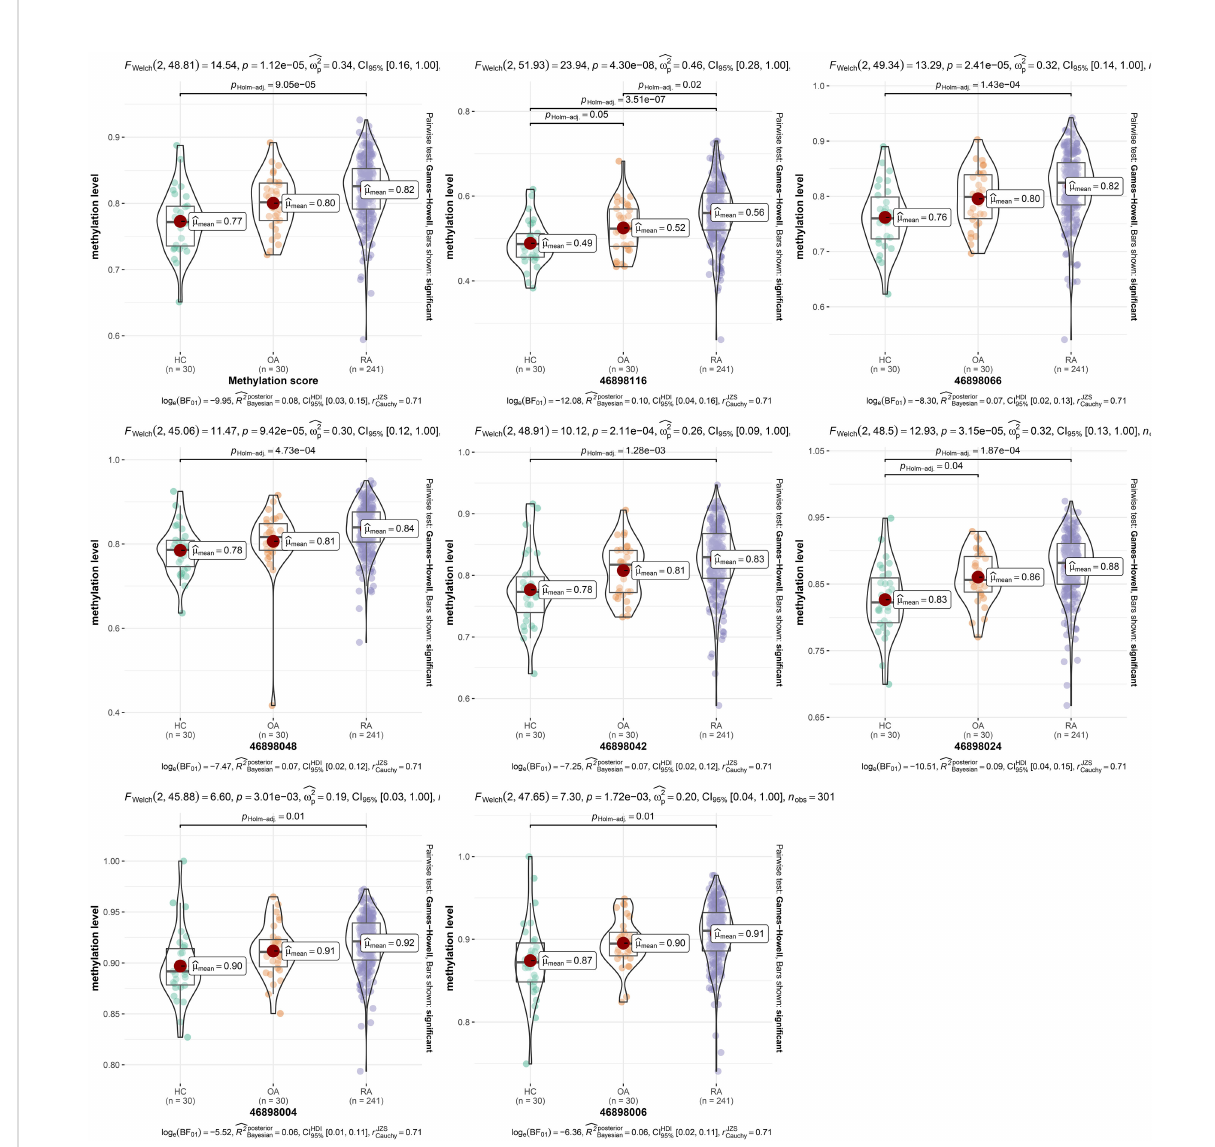
FIGURE 1 The methylation levels of different CpG sites. Comparison of methylation levels of different CpG sites of cg15692052 in RA, OA and HC groups using violin plot, FDR < 0.05 is statistically signi fi cant. RA, rheumatoid arthritis; OA, osteoarthritis patients; HC, healthy